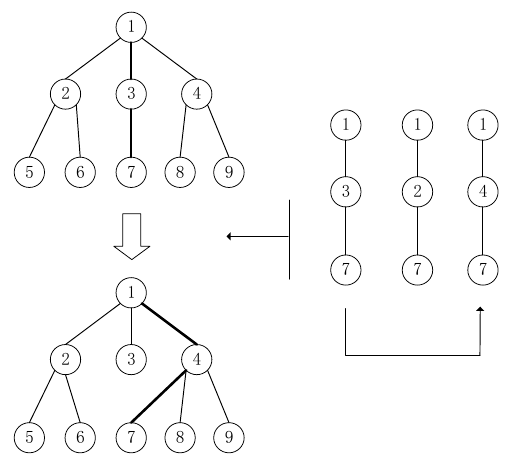
Figure 8. Example of the mutation operator.